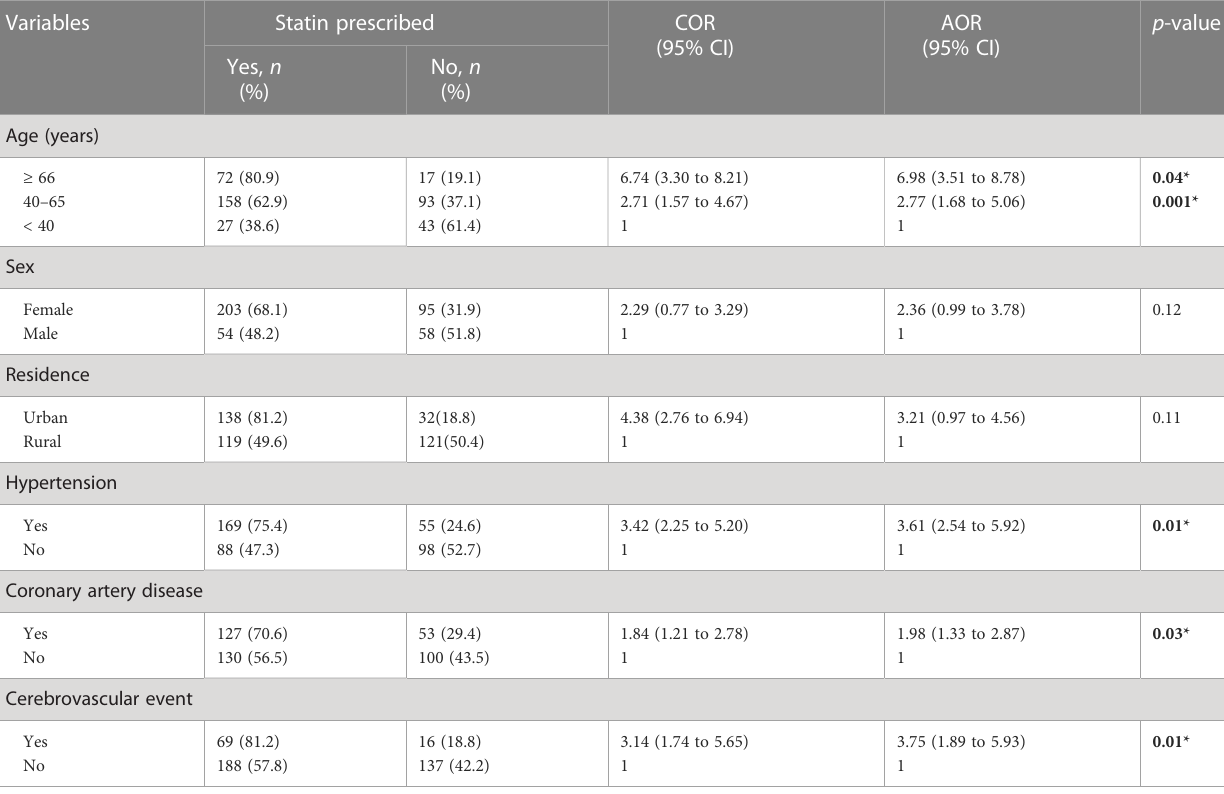
TABLE 3 Factors associated with statin prescription among statin-eligible patients with type 2 diabetes mellitus in Jugol General Hospital in Harar, eastern Ethiopia: 2022.